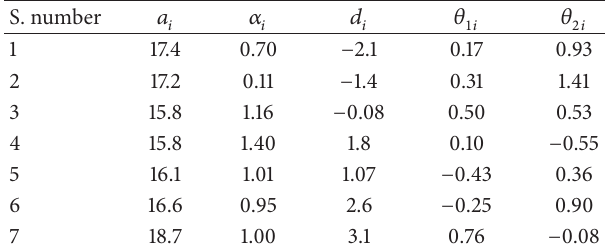
Table 5: Synthesis result: tasks included both specified position and